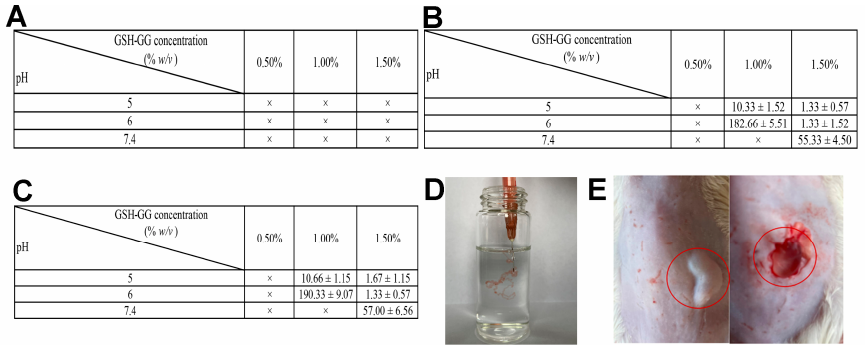
Figure 3. Injectability study of GSH-GG. The time (s) required for DOX-loaded GSH-GG to form a gel after adding ( A ) PBS, ( B ) CaCl 2 and ( C ) normal saline. ( D ) The gel formation image of DOX-loaded GSH-GG in normal saline. ( E ) The DOX-loaded GSH-GG was injected subcutaneously into the mice (left), and the in-situ gel (right) was observed after the skin was cut open.